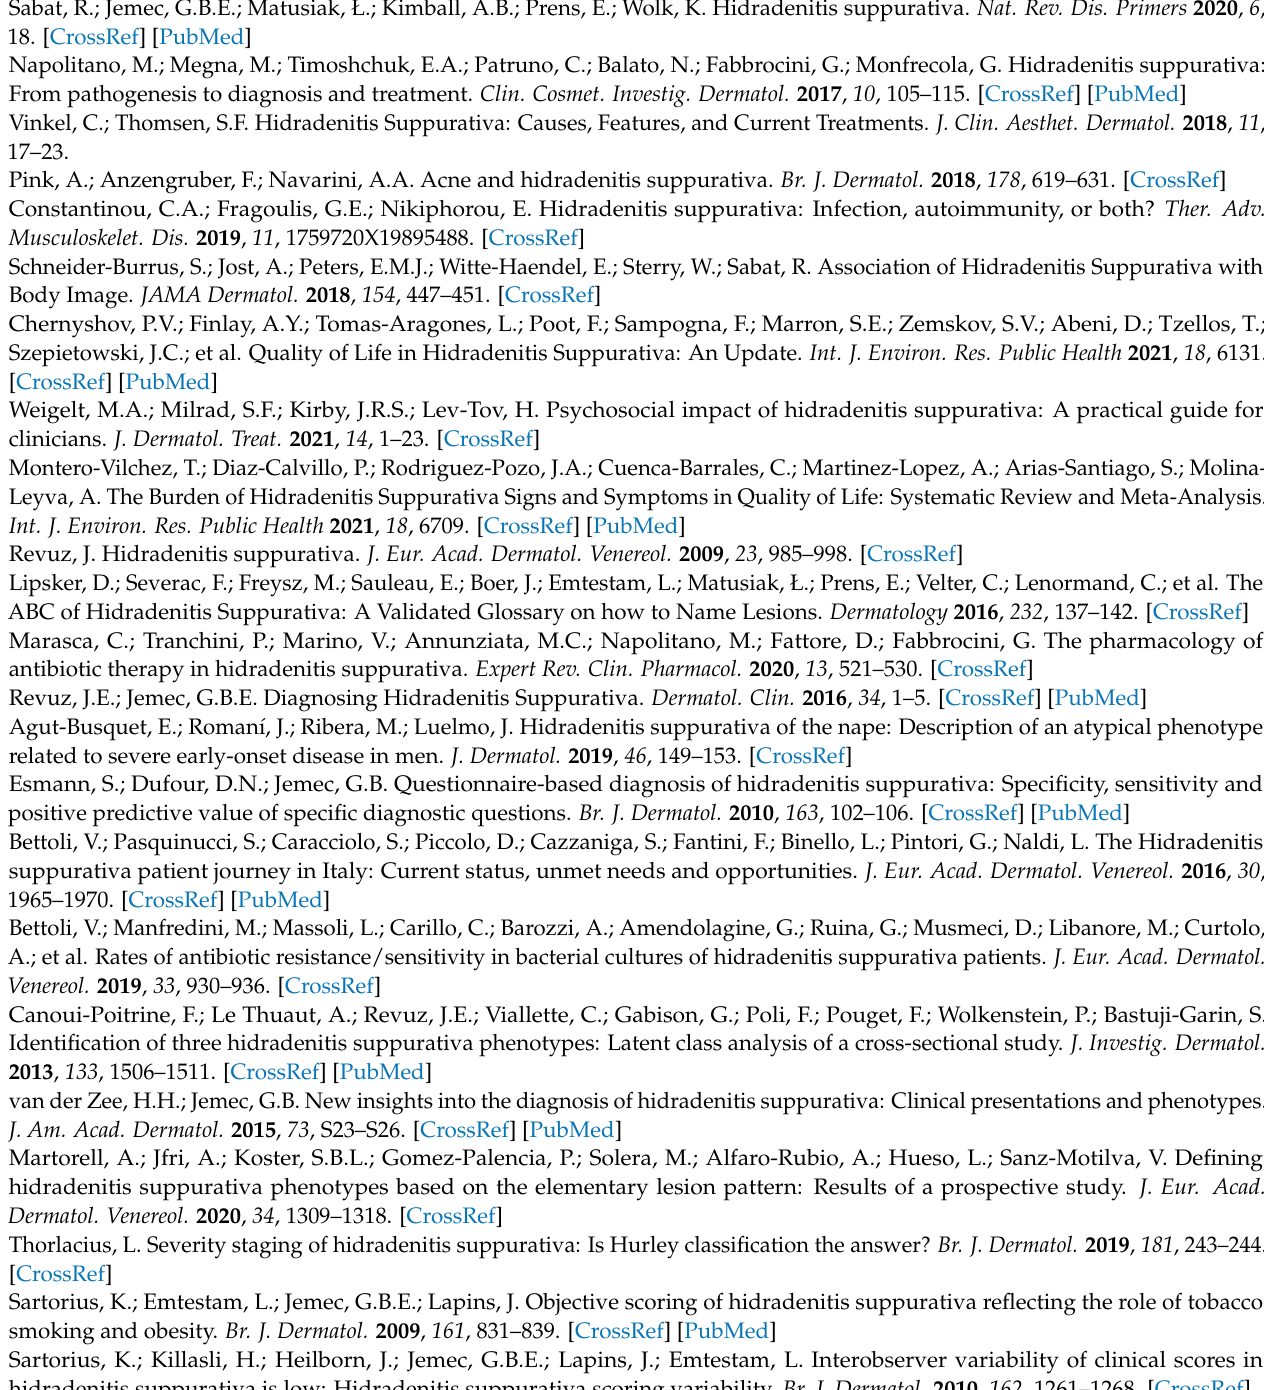
Data Availability Statement: The Figure 3 “Pathophysiology of HS: a schematic overview” has been adapted from the following source: